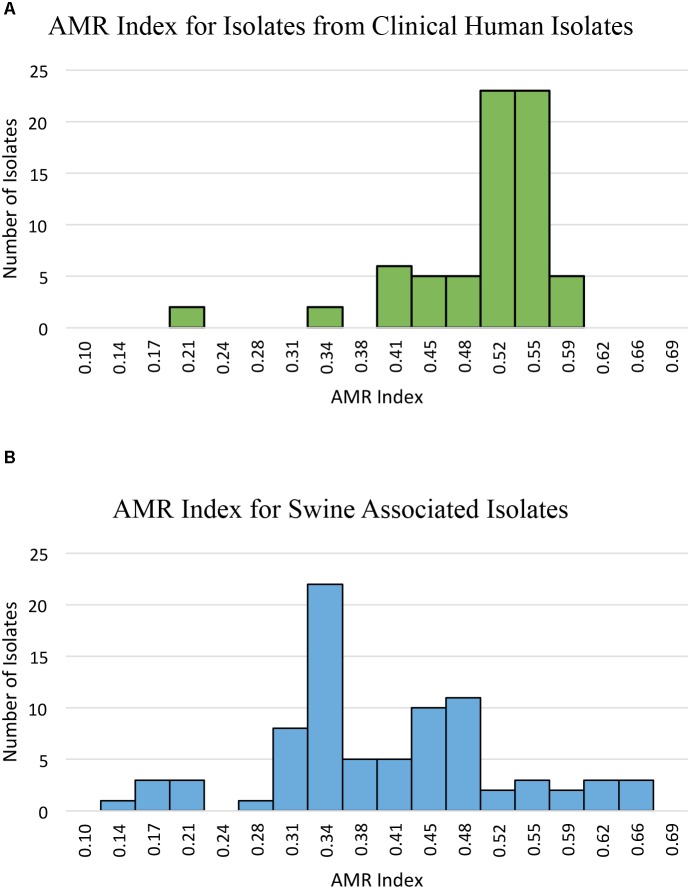
AMR index of isolates from clinical MRSA ST5 and swine associated LA-MRSA ST5. AMR index is defined as the proportion of the tested antibiotics to which an isolate is phenotypically resistant. (A) The AMR indexes determined for clinical isolates show a range of 0.21–0.59 with an average AMR index of 0.50. (B) The AMR indexes determined for swine associated LA-MRSA ST5 isolates. Swine associated isolates had AMR indexes with a wider range (0.14–0.66) and higher maximum AMR index; however, the average AMR index was 0.40, which was significantly less than that of clinical isolates (P < 0.0001).